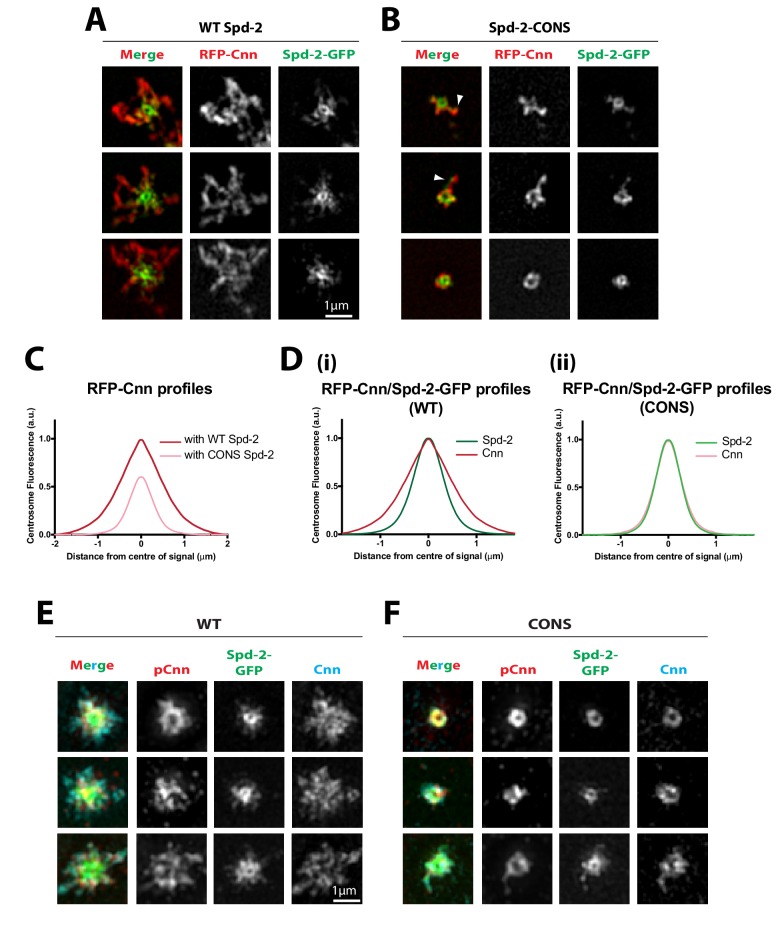
Cnn is recruited to, and phosphorylated at, centrioles in Spd-2-CONS embryos, but it does not efficiently assemble into an extended scaffold.(A,B) Micrographs show 3D-SIM images of individual centrosomes from living Spd-2 mutant embryos expressing RFP-Cnn (red in merged images) and either WT Spd-2-GFP (A) or Spd-2-CONS-GFP (B) (green in merged images). Arrowheads indicate examples of occasional protrusions of RFP-Cnn and Spd-2-CONS-GFP. (C,D) Graphs compare the radial distributions of RFP-Cnn around the mother centriole in WT Spd-2-GFP and Spd-2-CONS-GFP embryos (C), or the radial distribution of RFP-Cnn and Spd-2-GFP in either WT Spd-2-GFP (D[i]) or Spd-2-CONS-GFP embryos (D[ii]). Data for these graphs was obtained from living embryos examined on a spinning disk confocal system; five centrosomes per embryo were analysed: n = 8 and 7 embryos for WT and CONS embryos, respectively. (E,F) Micrographs show 3D-SIM images of individual centrosomes from Spd-2 mutant embryos expressing either WT Spd-2-GFP (E) or Spd-2-CONS-GFP (F) that were fixed and stained with antibodies against GFP, phospho-Cnn, or total-Cnn (green, red and cyan in merged images, respectively).10.7554/eLife.50130.029Figure 7—source data 1.Figure 7C,D source data; radial profile analysis.